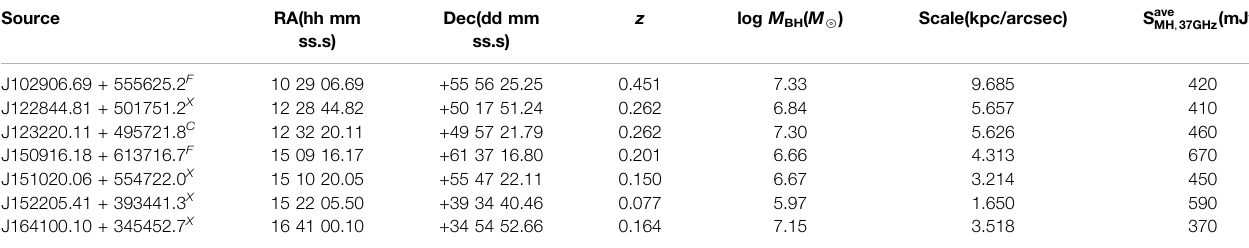
TABLE 1 | Summary of the source properties, and archival average Metsähovi fl ux densities. Source